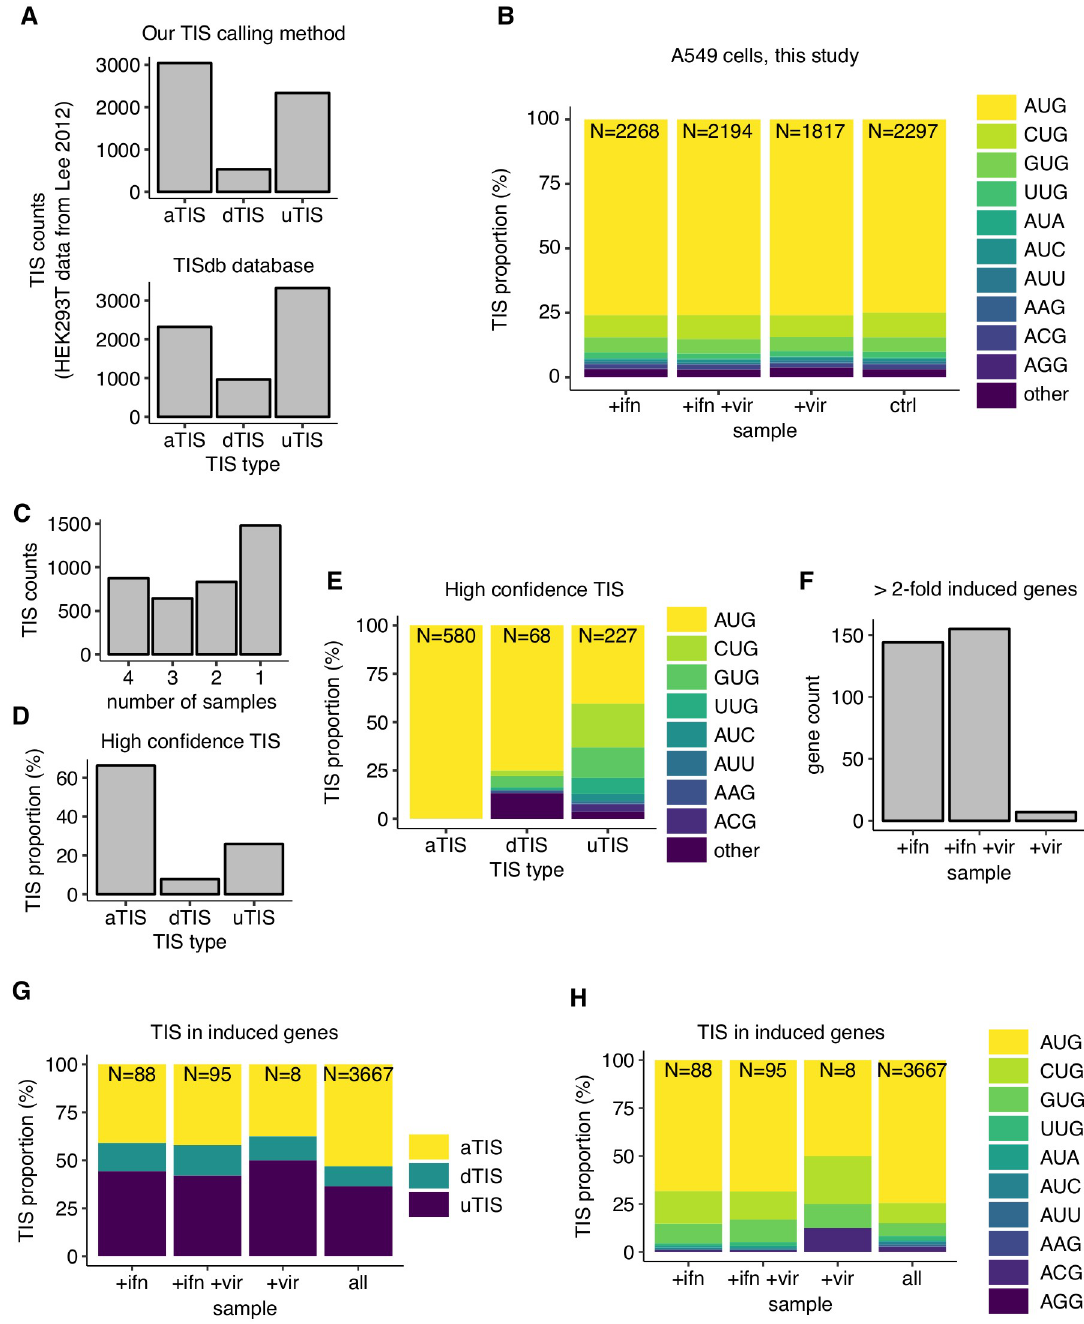
Fig 6. Translation initiation on human transcripts during influenza infection and anti-viral response. (A) Number of different TIS types—aTIS, dTIS and uTIS—called using our start site calling method (upper panel) or in the TISdb database [85] (lower panel). See main text for description of our calling method. (B) Proportion of different near-cognate AUG codons (or other codons) at the called TIS in each of the four samples in our study. N at the top of each bar indicates the total number of TIS called in each sample. (C) Overlap among TIS called in each of the 4 samples. Vertical axis indicates the number of TIS that are called in a given number of samples as indicated along the horizontal axis. (D) Proportion of each TIS type that are called in all 4 samples (designated as high-confidence TIS). (E) Proportion of different near-cognate AUG codons (or other codons) among the high-confidence TIS, stratified by TIS type. N at the top of each bar indicates the total number of high-confidence TIS of each type. (F) Number of genes that are induced greater than 2-fold (median-normalized counts, RNA-seq and Ribo-seq treated as replicates) upon +ifn, +ifn +vir, or +vir treatment with respect to the control untreated sample. (G) Proportion of different TIS types among induced genes shown in F. The set of all TIS called in at least one